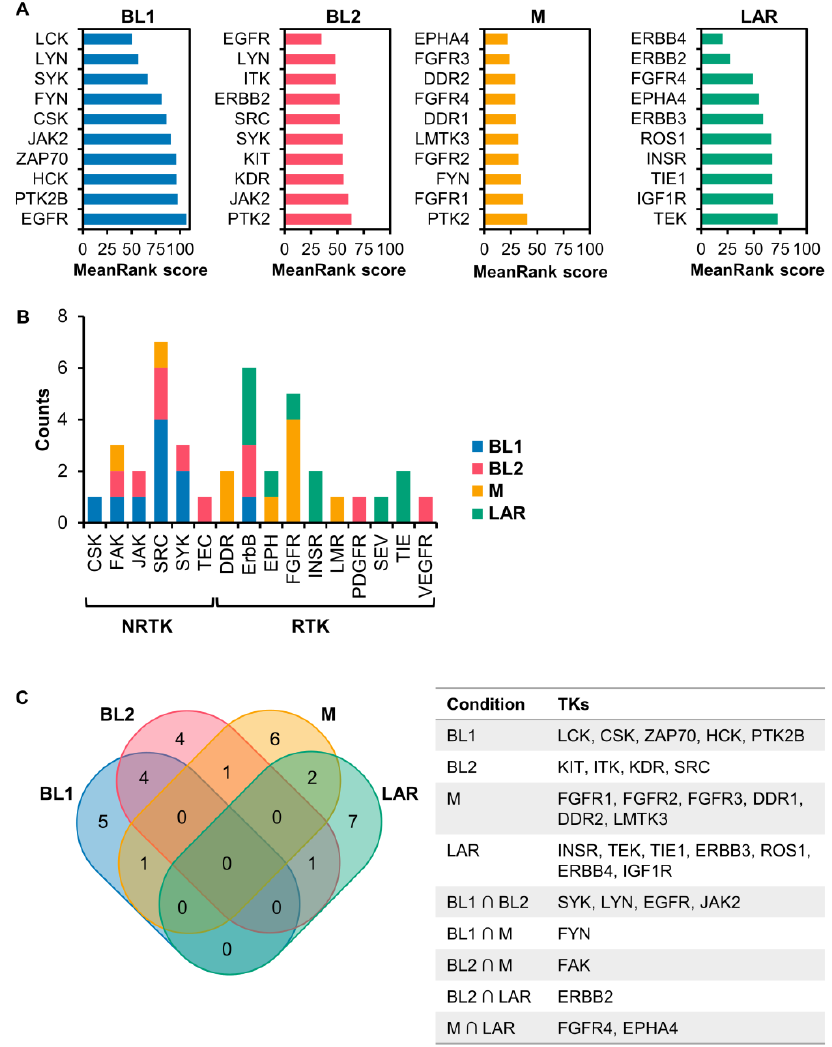
Figure 3. Kinase enrichment analysis. ( A ) Top ten predicted TKs from KEA3 based on MeanRank score. ( B ) Distribution of non-receptor (NRTKs) and receptor TKs (RTKs). TKs from ( A ) were